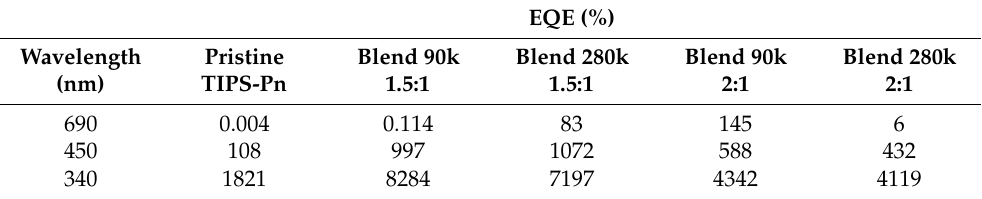
Figure 6. ( a ) Photoresponsivity and ( b ) detectivity of the fabricated TFTs under irradiation light of 690, 450, and 340 nm. Table 2. EQE for the fabricated TFTs under irradiation light of 690, 450, and 340 nm calculated using Equation